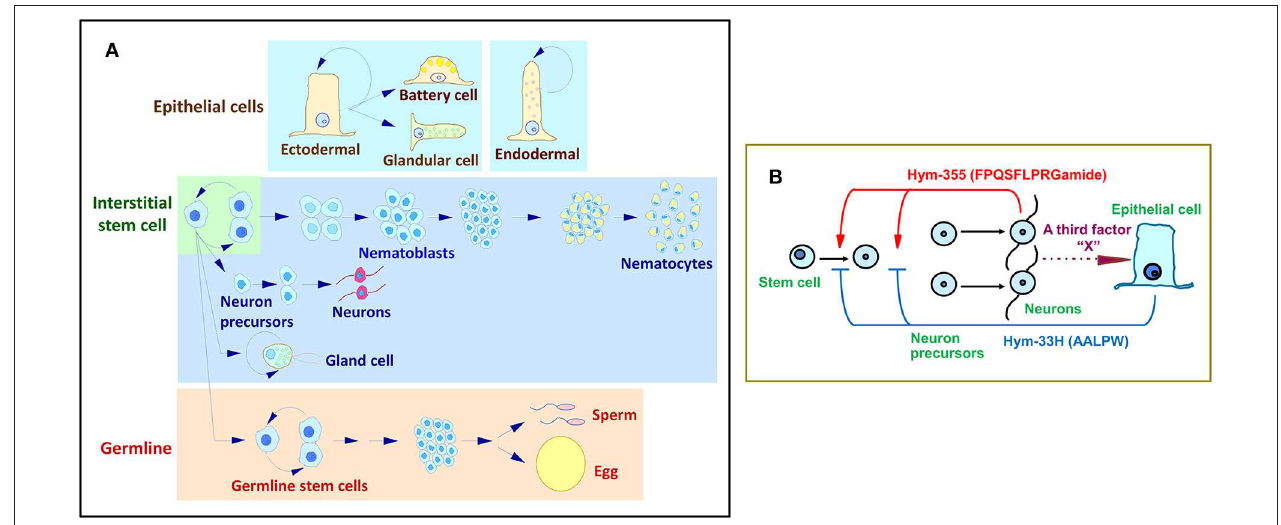
FIGURE 3 | Hydra stem cell system. (A) Cell differentiation in Hydra . (B) A feedback model for the control of neuron differentiation that involves the antagonistic action of Hym-355 and the PW peptide, Hym-33H.